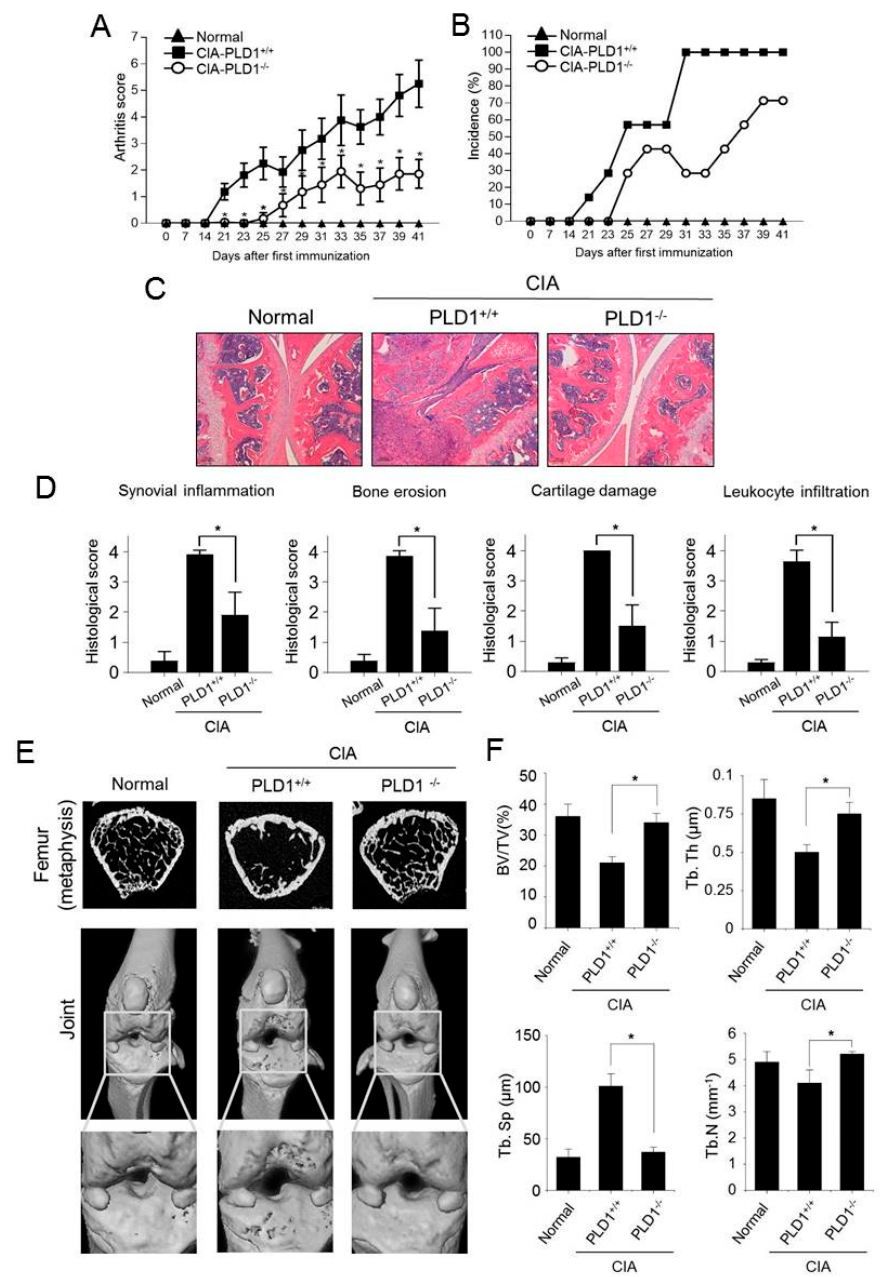
Figure 1. PLD1 deficiency reduces disease severity and joint inflammation in collagen-induced arthritis (CIA) mice. ( A ) Clinical arthritis scores were determined in CIA-challenged PLD1 +/+ and PLD1 − / − mice. ( B ) Incidence of CIA, as scored in all paws. ( C ) Hematoxylin and eosin staining of knee joint sections from the indicated mice at day 42. ( D ) Histological assessment of the pathological features of mice knee joints at day 42. ( E ) Representative micro-computerized tomography images of femurs and knee joints of mice at day 42 (top—transverse sections of metaphysis; middle—three-dimensional reconstructed knee joint; bottom—magnified view) ( F ) Histomorphometric analysis of the bone for each group, showing bone volume (BV) / tissue volume (TV) ratio, trabecular bone thickness (Tb.Th), trabecular separation (Tb.Sp), and trabecular number (Tb.N). n = 15 per group. * p < 0.05. Quantitative results are shown as mean ± standard error of the mean